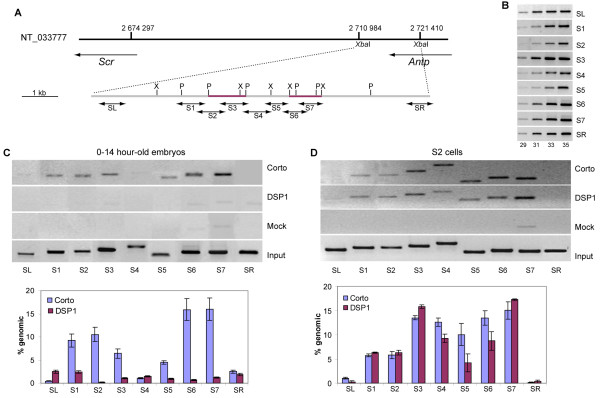
Binding of Corto on the Scr 10-kb XbaI fragment. (A) The 10-kb XbaI Scr fragment is located about 37-kb upstream from the transcription start site. Numbers refer to NT_033777, i.e. the access number of the complete sequence of the Drosophila melanogaster 3R chromosome. The 7 internal sequences (S1 to S7) and the two distal sequences (SL and SR) were amplified with specific primers as described in Methods. The PvuII and XmnI fragments, where DSP1 has been previously shown to bind, are in purple [41]. (B) To determine the linear range of amplification, PCR samples were taken at the 29th, 31st, 33rd and 35th PCR cycles. (C-D) Chromatin immunoprecipitation analysis of 0–14 hour-old embryos (C) or S2 cells (D) using rabbit anti-Corto, rabbit anti-DSP1 or rabbit serum as a control (mock). The 31st cycle samples were loaded on a 1% agarose gel. The PCR products were quantified using Image J software and expressed as a percentage of the total input DNA. The diagrams represent the mean of 3 independent experiments.